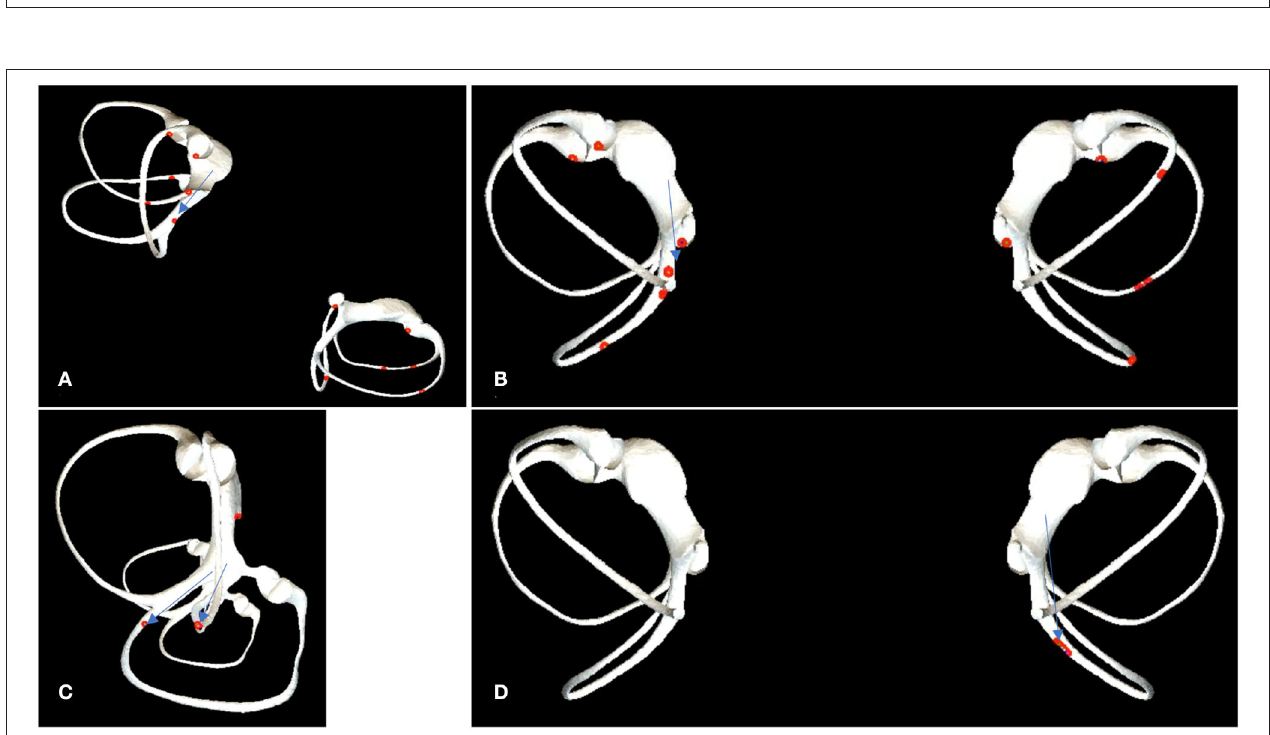
FIGURE 3 | Canal switch scenarios. (A) The right Epley maneuver, step C. The patient quickly lies back, supine, with his head hanging at 30 ◦ . The otoliths in the short arm of the left lateral semicircular canal and the left utricle enter the superior semicircular canal, resulting in BPPV of the left superior semicircular canal. (B) In the right Barbecue maneuver, step D. Supine position, the otoliths in the short arm of the left lateral semicircular canal and the left utricle enter the posterior semicircular canal, resulting in BPPV of the left posterior semicircular canal. (C) Head tilted back 70 ◦ , the otoliths in the utricle enter the posterior or the lateral semicircular canal. (D) Head tilted back 90 ◦ , the otoliths in the utricle enter the posterior semicircular canal.